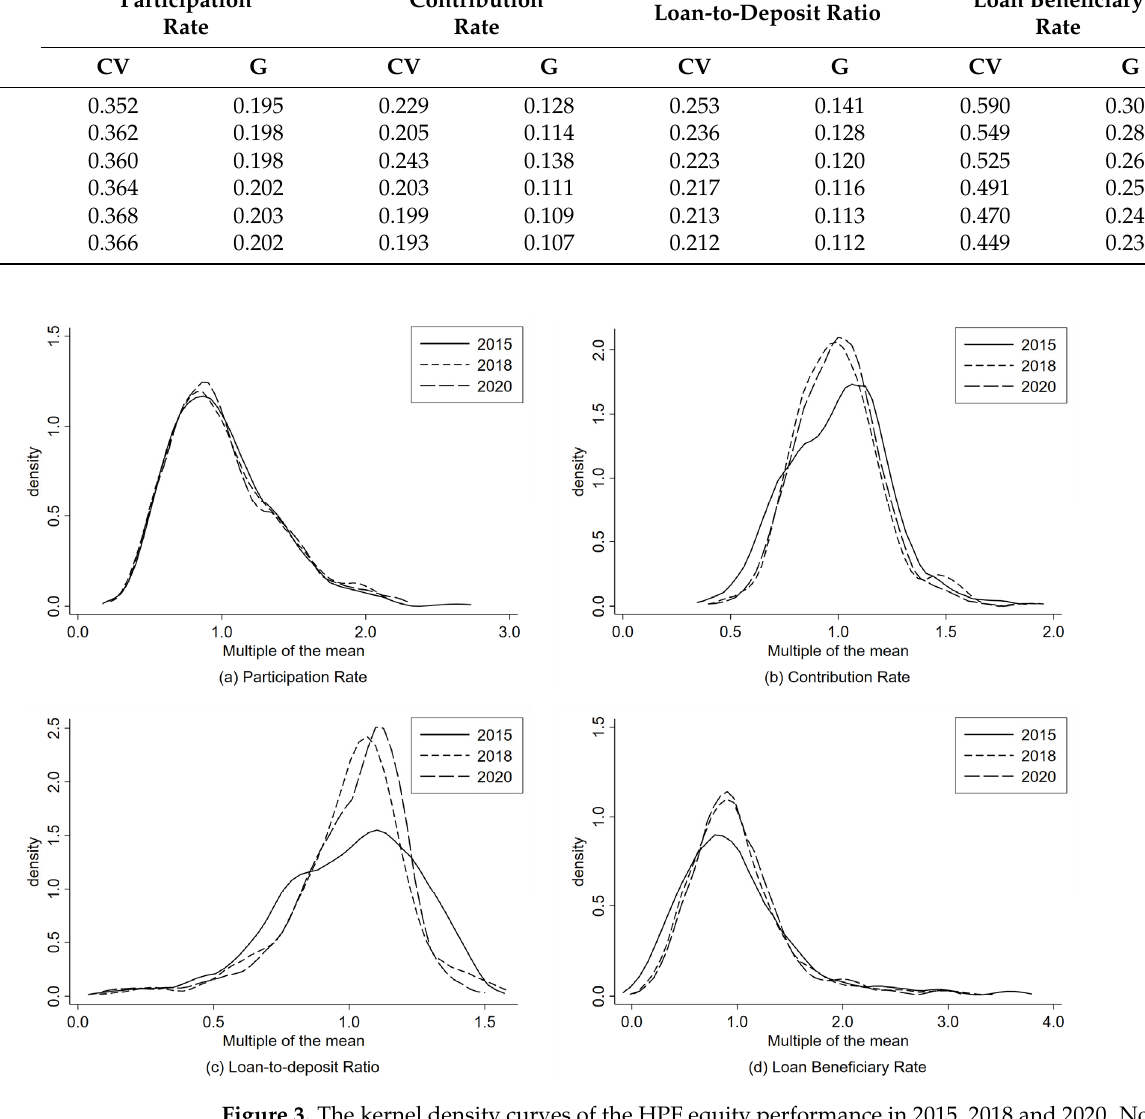
Figure 3. The kernel density curves of the HPF equity performance in 2015, 2018 and 2020. Note: To accomplish the dynamic comparability of time series, we adopt the mean value processing, that is, the value of each city is divided by the mean value of all cities in that year.